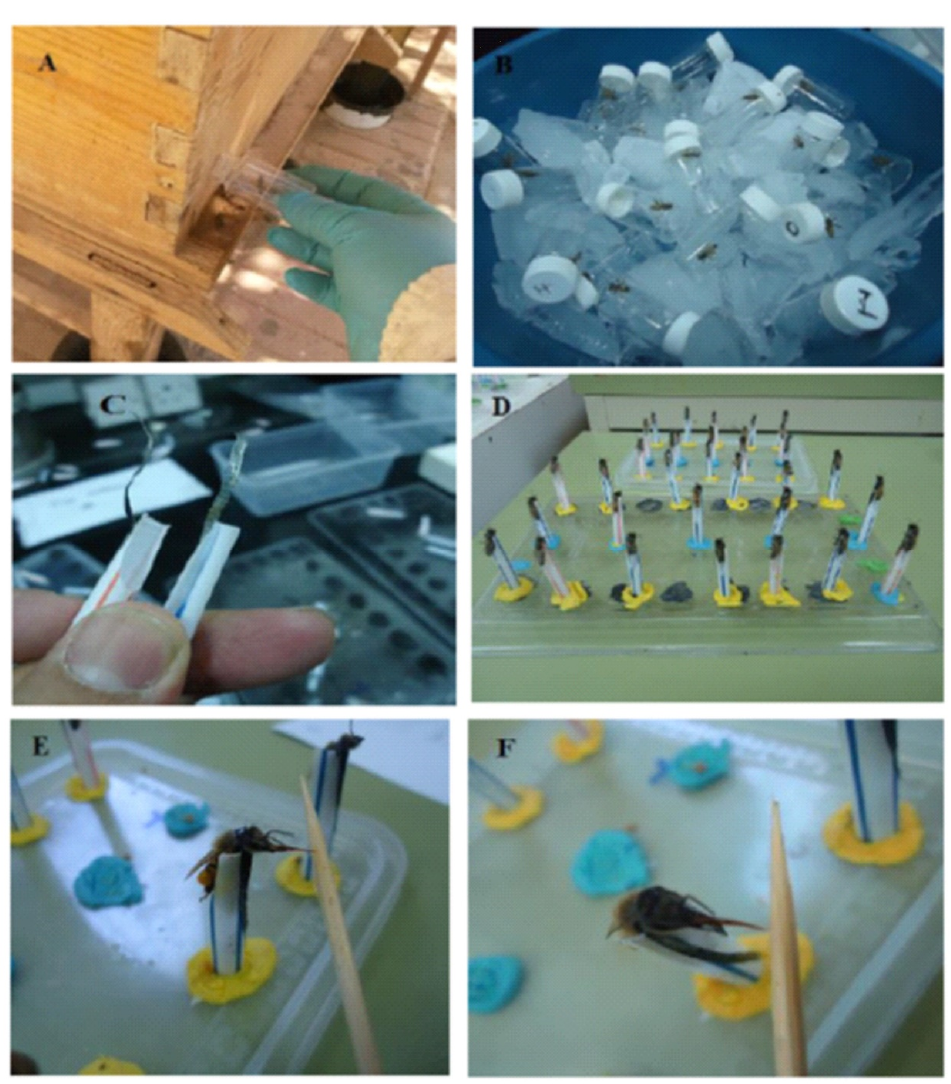
Figure 9. Experimental methodology. ( A ) Collection of bees; ( B ) vials on ice; ( C ) harnessing tubes (made from straws); ( D ) different subspecies after harnessing; ( E ) feeding bees before testing; ( F ) proboscis extension response testing.